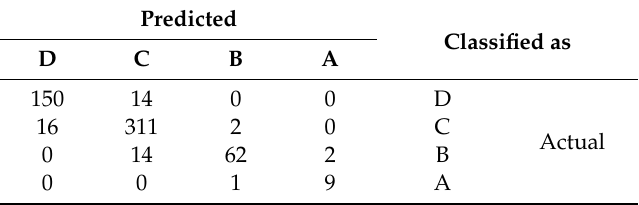
Figure 5. Variation of ∆ E / E 1 versus F r1 along with the ranges of smooth and rough regimes and hydraulic jump classes (A, B, C, D). Table 7. Confusion matrix of the decision tree for all rough